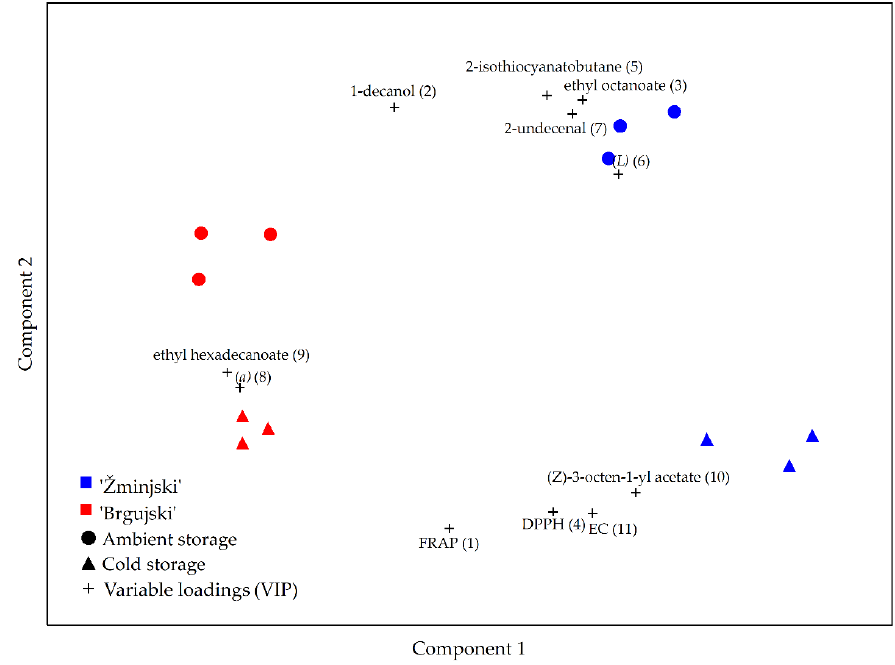
Figure 4. Influence of storage conditions (ambient and cold) and cabbage cultivar ‘Brgujski’ and ‘Žminjski’ on physicochemical and phytochemical sauerkraut parameters using PLS-DA. In the samples stored in a cold setting, the (Z)-3-octen-1-yl acetate content was higher compared to that in the samples stored in an ambient setting, but only in the ‘Žminjski’ sauerkraut (Figure 4). Being one of the constituents of cabbage’s essential oil, the com- pound is much more diffused due to the mechanical wounding of the plant’s cell structure prior to cold storage [56]. Although it converts into its alcohol derivate by hydrolysis, the secondary alcohol formed is then converted into ketone by oxidation [57]. Both reactions are initiated due to mechanical wounding and catalyzed by enzymes [57]. The lower tem- perature in the cold storage significantly inhibits the enzymatic activity and, therefore, a higher (Z)-3-octen-1-yl acetate content was detected [58]. According to the developed model, EC is responsible for the differentiation between sauerkraut of local cultivars as well as between the storage conditions of ‘Žminjski’ sau- erkraut. According to Żywica et al. [59], the sample mineral composition can significantly affect the EC. A possible cause as to why the ‘Žminjski’ sauerkraut sample stored in the ambient setting exhibited a lower EC value could be due to the higher storage tempera- ture, which leads to increased diffusion of the ions and molecules into the brine, conse- quently decreasing the EC of the cabbage itself. However, in cold storage, due to the lower storage temperature, the diffusion of particles was slower, thus making the EC of the cab- bage increase. The sensory analysis of sauerkraut samples did not show significant differences be- tween different storage conditions, as well as traditional cultivars (data not shown). 4. Conclusions